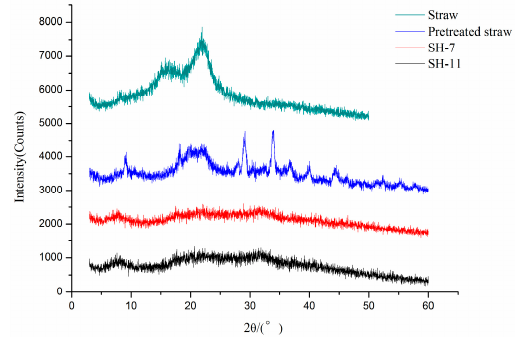
Figure 2. XRD of straw, pretreated straw and hydrogels.